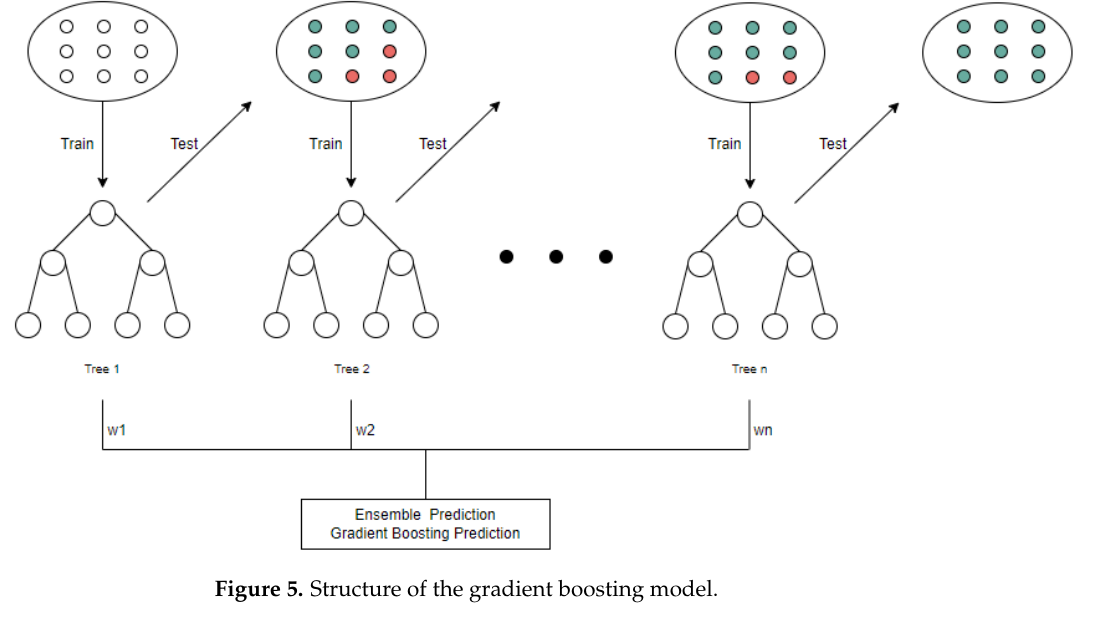
Figure 5. Structure of the gradient boosting model.